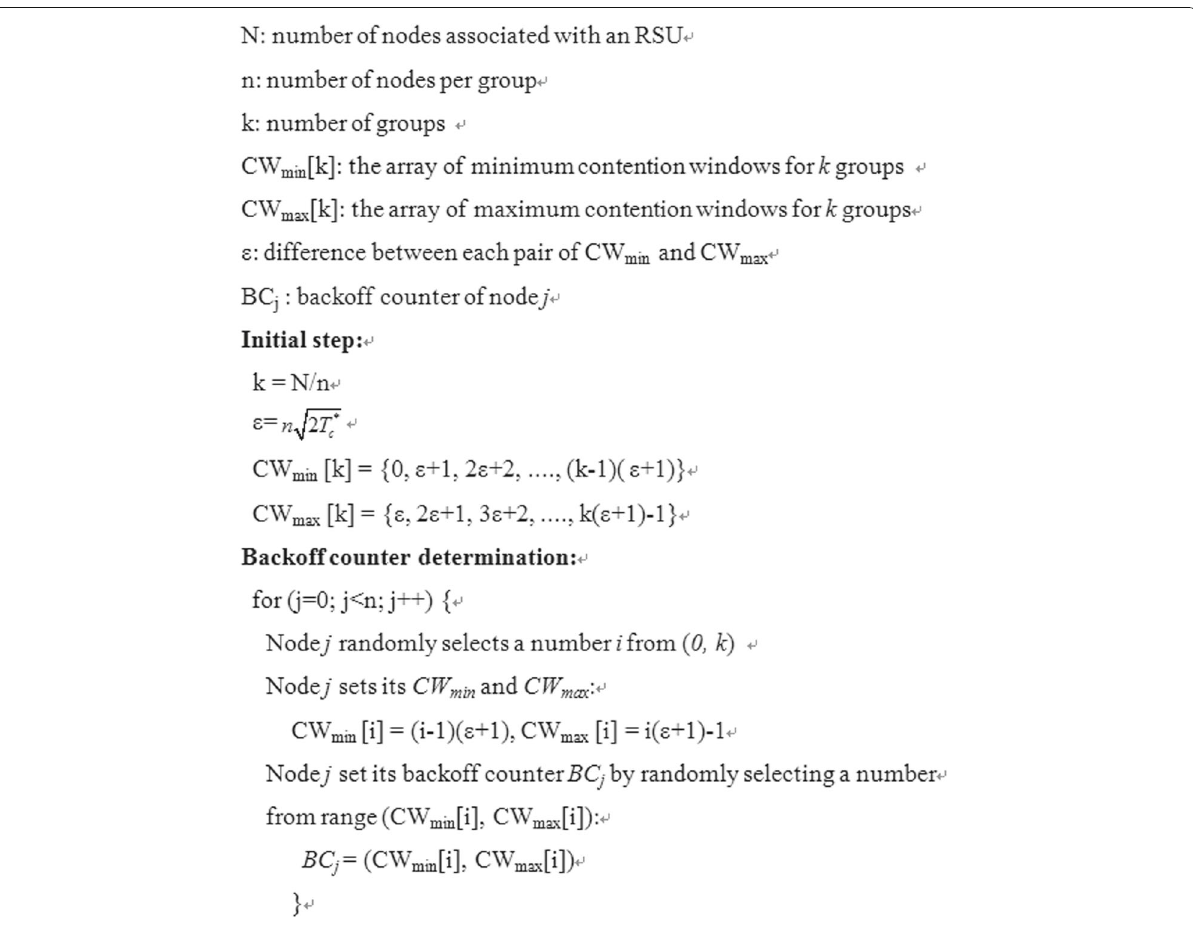
Fig. 2 Random contention window selection